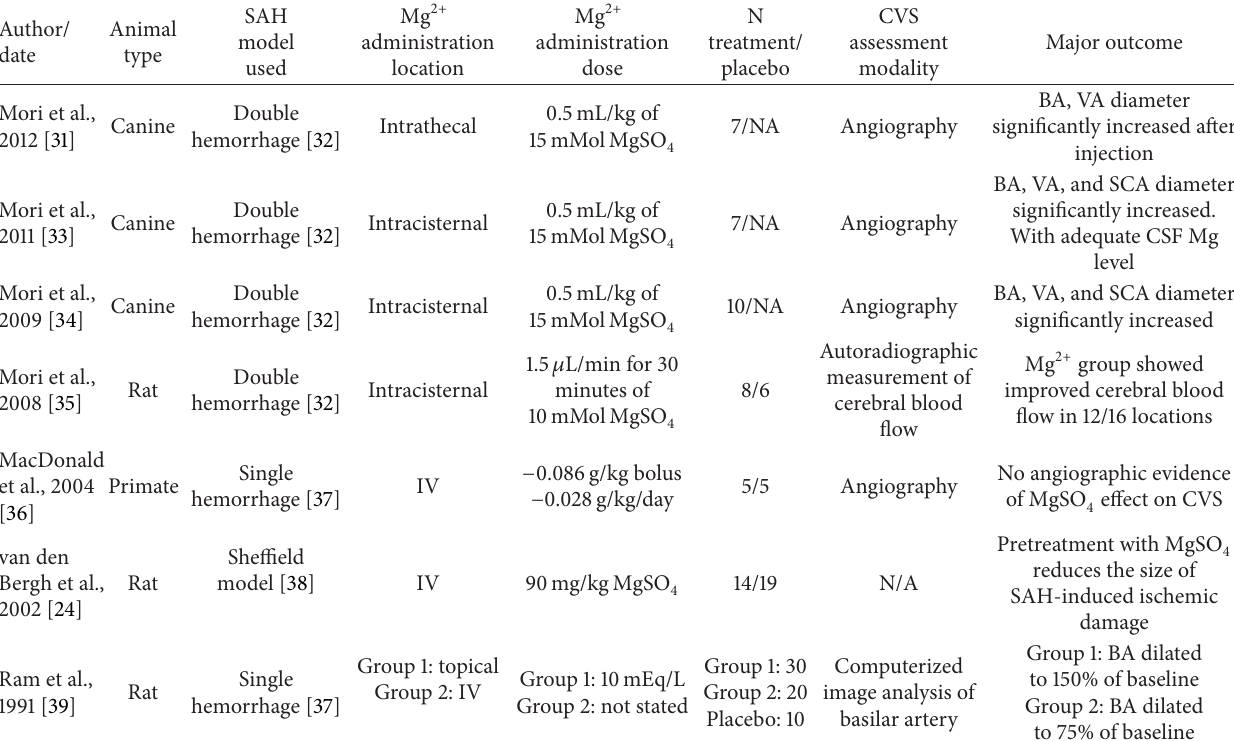
Table 1: Summary of in vivo animal models of SAH/CVS and magnesium